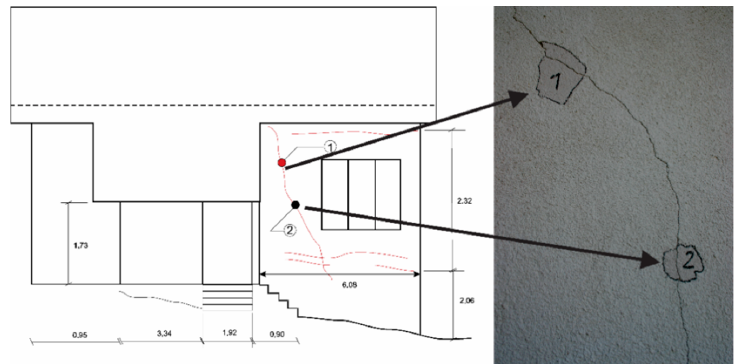
Figure 5. Measurements of the crack width on the building.